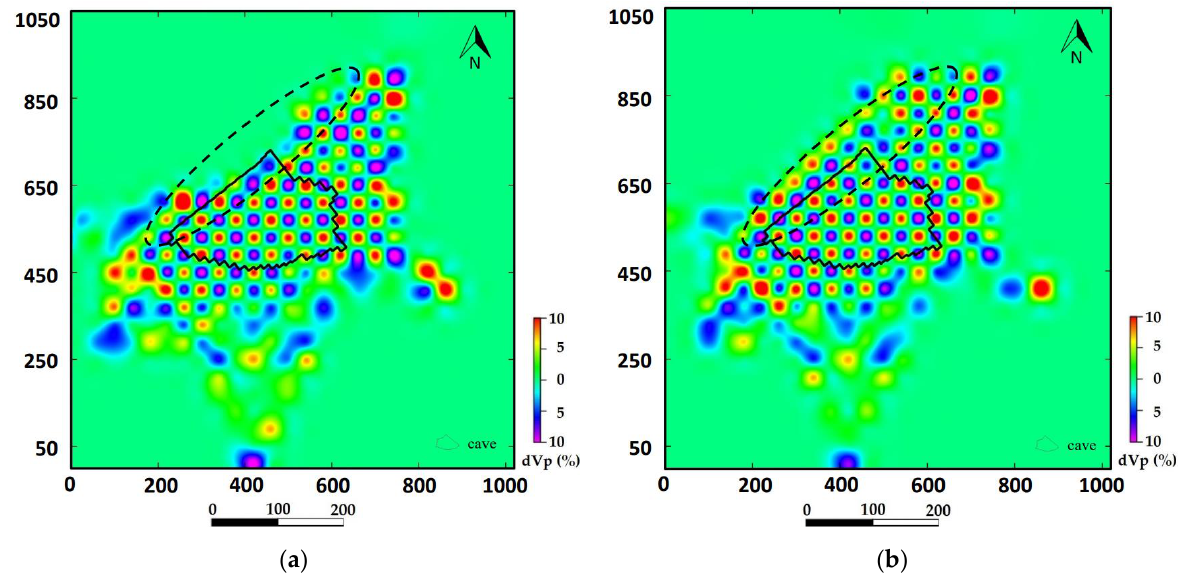
Figure 9. ( a ) The results of the Checkerboard Resolution Test Vp scenario following the facilities in the abutment zone (elevation 1620 msl). ( b ) The results of the Checkerboard Resolution Test Vp off- facilities scenario in the abutment zone (elevation 1620 msl). The cave is indicated by a black trian- gle.